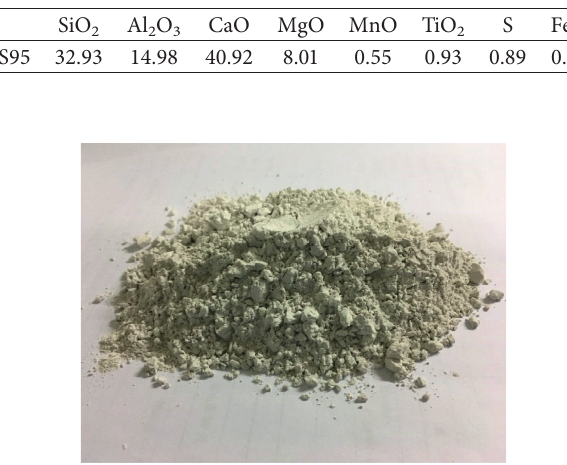
Figure 1: Photograph of blast furnace